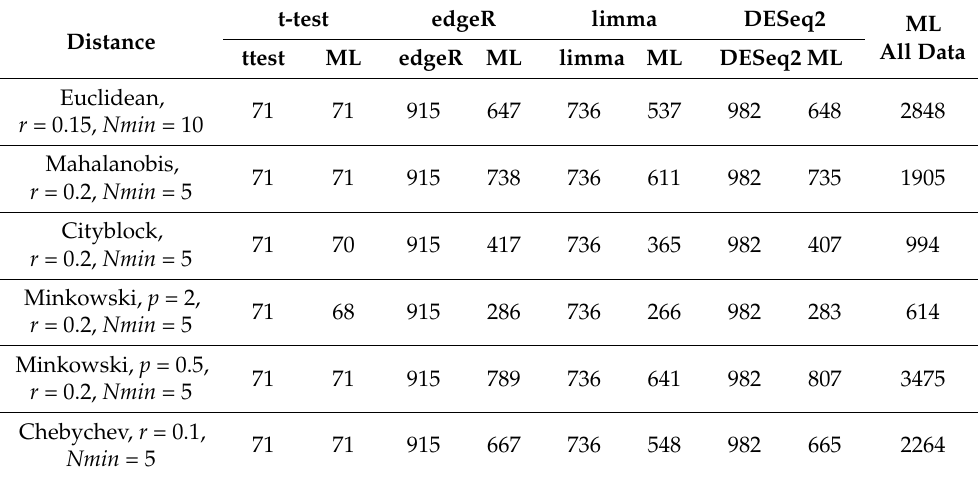
Table 1. The number of differentially expressed genes selected through different cluster distances compared with the results of statistical gene differentiation; batch = 511